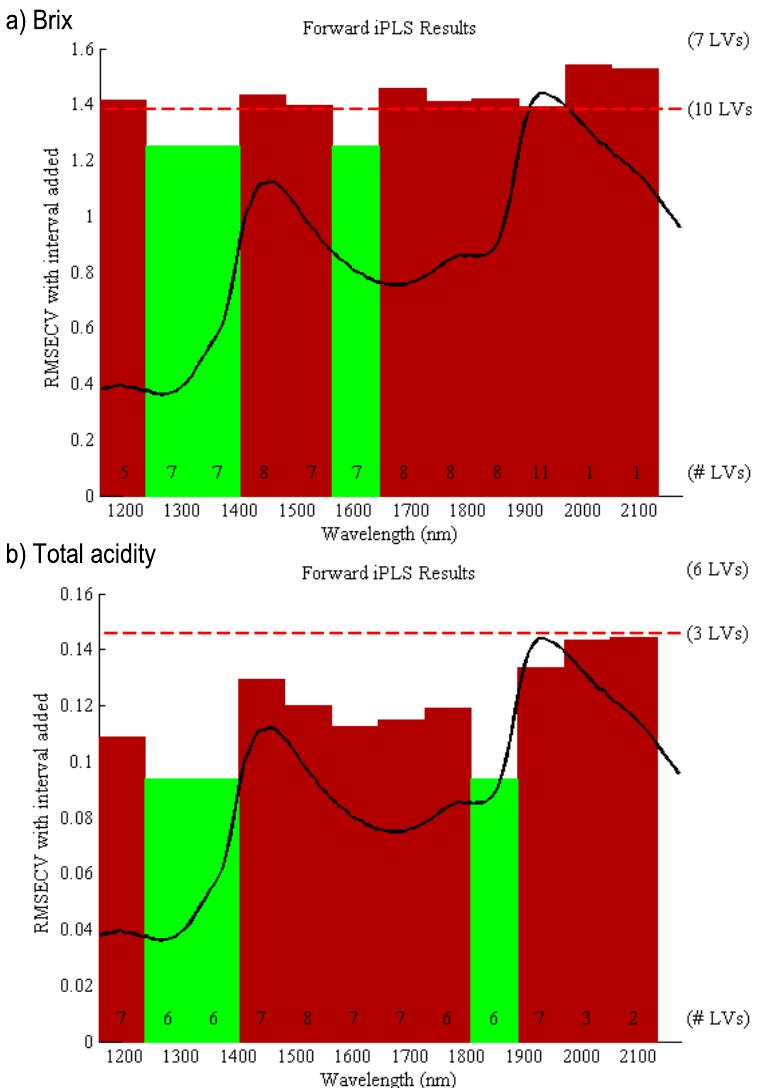
Figure 2. Spectral average (black line) of the MicroNIR spectra from different genotypes of cashew. The relevant absorbance selected by the iPLS model (green) for the genotype discrimination based on ( a ) °Brix and ( b ) total acidity.